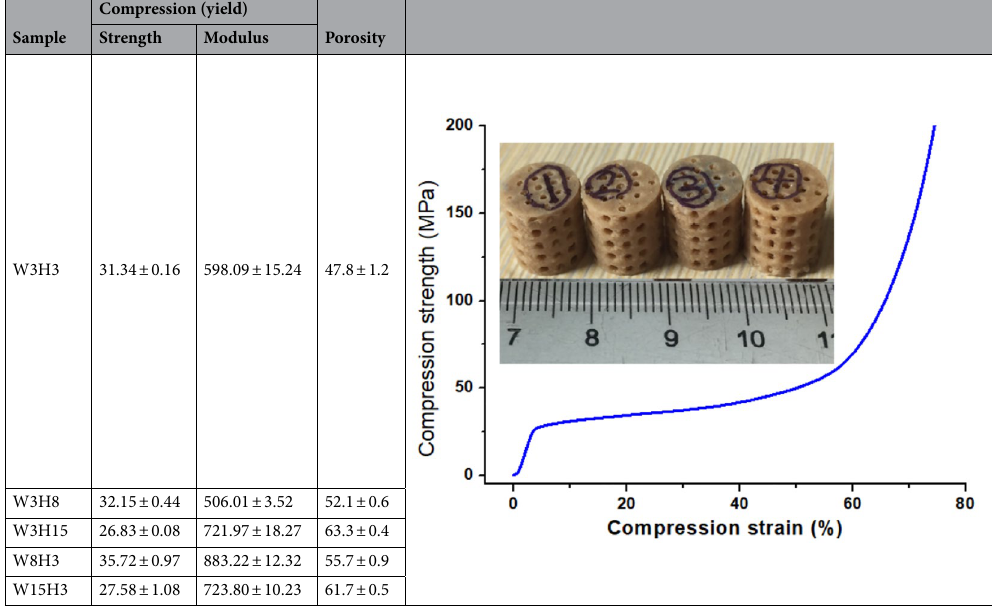
Table 4. Compression properties of PLA/WS/HA